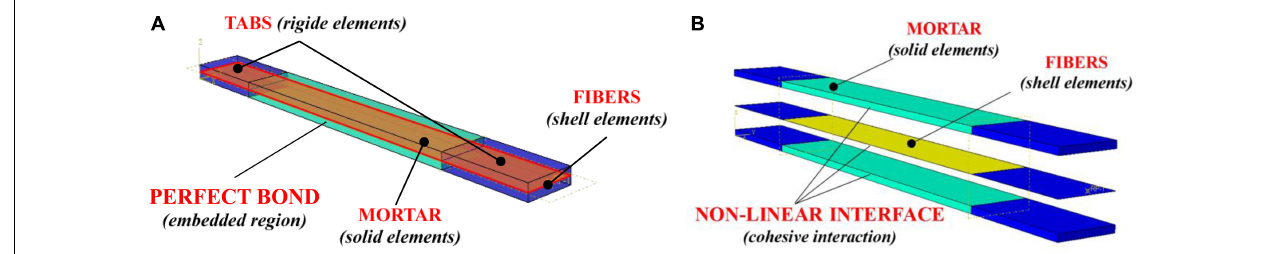
FIGURE 4 | Model types: (A) model T1; (B) model T2.